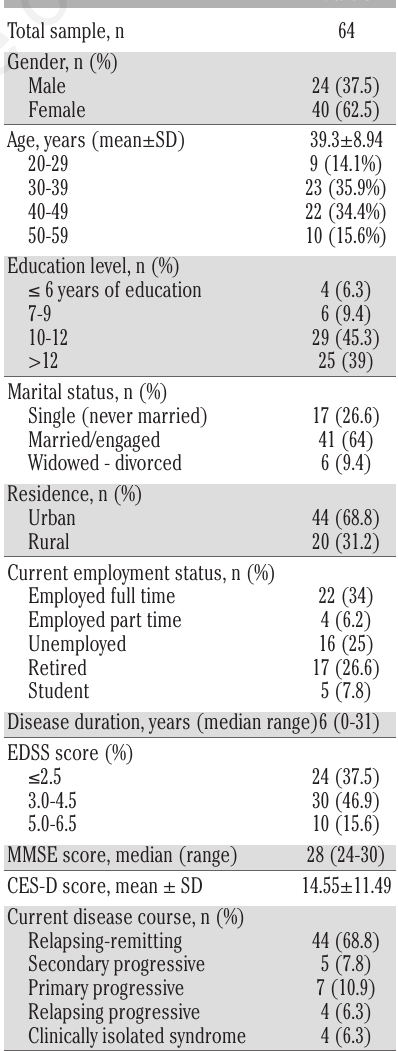
Table 1. Demographic and disease charac- teristics of the study